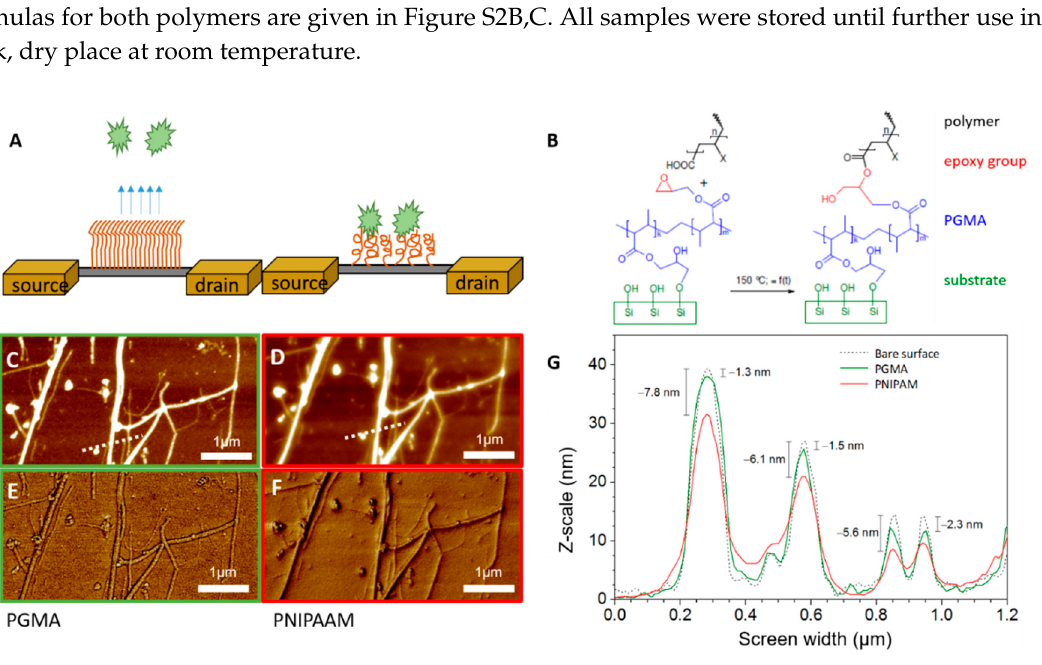
Figure 2. Functionalization of FETs with polymer brush PNIPAAM. ( A ) Schematic representation